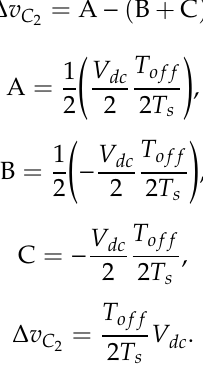
Figure 8. Variation of T of f according to the current i p magnitude ( R on = 23.5 Ω R of f = 23.5 Ω ); ( a ) i p = R = 23.5 Ω ); ( a ) R = 23.5 Ω Figure 8. Variation of off T according to the current p i magnitude ( 170 mA; ( b ) i p = 250 mA; ( c ) i p = 330 mA; ( d ) i p = 600 off on i = 170 mA; ( b ) i = 250 mA; ( c ) i = 330 mA; ( d ) i = 600 mA. p p p p